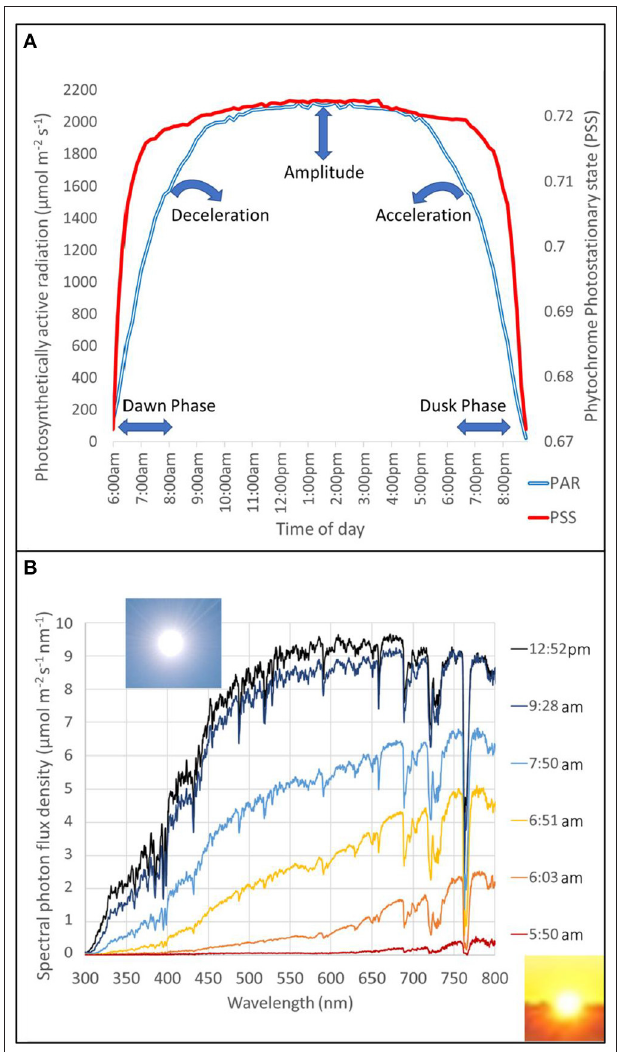
FIGURE 1 | A simple model of seasonal and latitudinal zeitgeber patterns for plants and daily solar spectral shifts. Gating circadian light inputs during dawn and dusk is logical when considering the natural solar spectral shifts. There is a dramatic change in light quality and intensity during the first 2h of the photoperiod whereas there is a minor change during the hours approaching solar noon (A,B) . Spectral change during time-of-day (dawn to solar noon) with a few timepoints highlighted, and others omitted for clarity, is emphasized to note the difference between morning and solar noon (B) . Measurements were taken every 10min using Flame-S-XR1 (Ocean Optics Inc, Florida, USA) on Oceanview software with a 10 µ m slit grating, 100ms integration time, and a cosine corrector (CC-3-UV-S) pointed directly at the sun at every timepoint during the 2017 summer solstice in Guelph, Ontario, Canada (43.5 ◦ N, 80.2 ◦ W). Using this day-long dataset and datasets from different seasons (data not shown), timepoints were transformed to solar elevations using sun path maps (Oregon, 2007) to model the seasonal, and latitudinal trends (A) . Phytochrome photostationary state (PSS) (Sager et al., 1988), was calculated to represent plant perceived light quality shifts, and photosynthetically active radiation (PAR) was calculated to represent plant perceived light intensity shifts (A) . The daily pattern changes only in phase and amplitude over the seasons. It changes in phase, amplitude, and deceleration/acceleration across latitudes. Acceleration refers to differences in non-linear slopes of PAR and PSS. Acceleration of spectral change relates to Webb et al. (2019)